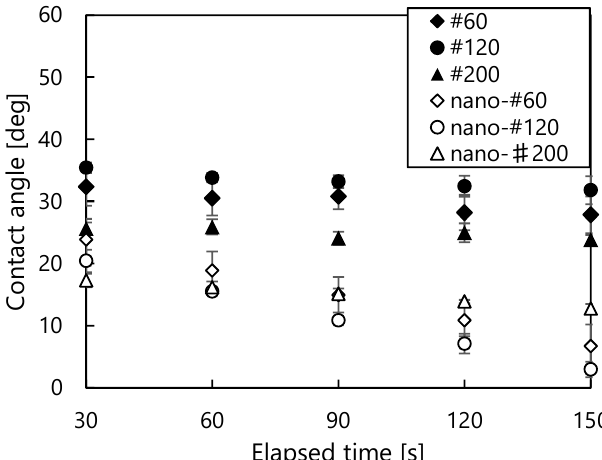
Figure 3. Contact angle as a function of elapsed time on mesh